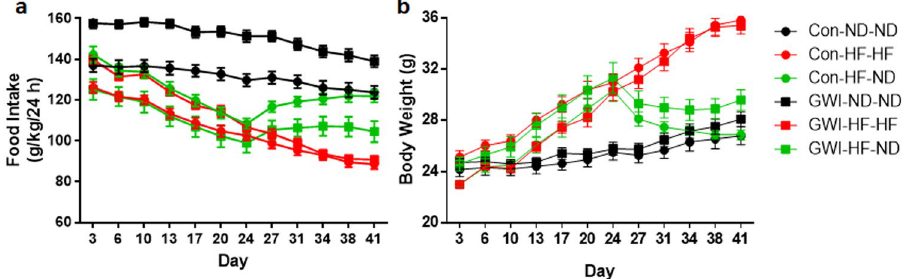
Figure 2. Effect of diet on food intake ( A ) and body weight ( B ). Mice were treated with GWI agents or Con (control) and then fed a normal (ND) or high fat (HF) diet for 3 weeks. Thereafter, half of the mice on the HF diet (Con and GWI) were switched to ND (HF-ND) for an additional 3 weeks. Remaining GWI and Con mice were fed ND or HF diet throughout (ND-ND or HF-HF). Food intake measures were calculated based on food consumption (g), mouse body weight (kg) for a 24 h period and reported as g/kg/24 h. Results are mean ± SEM, N = 7–9.